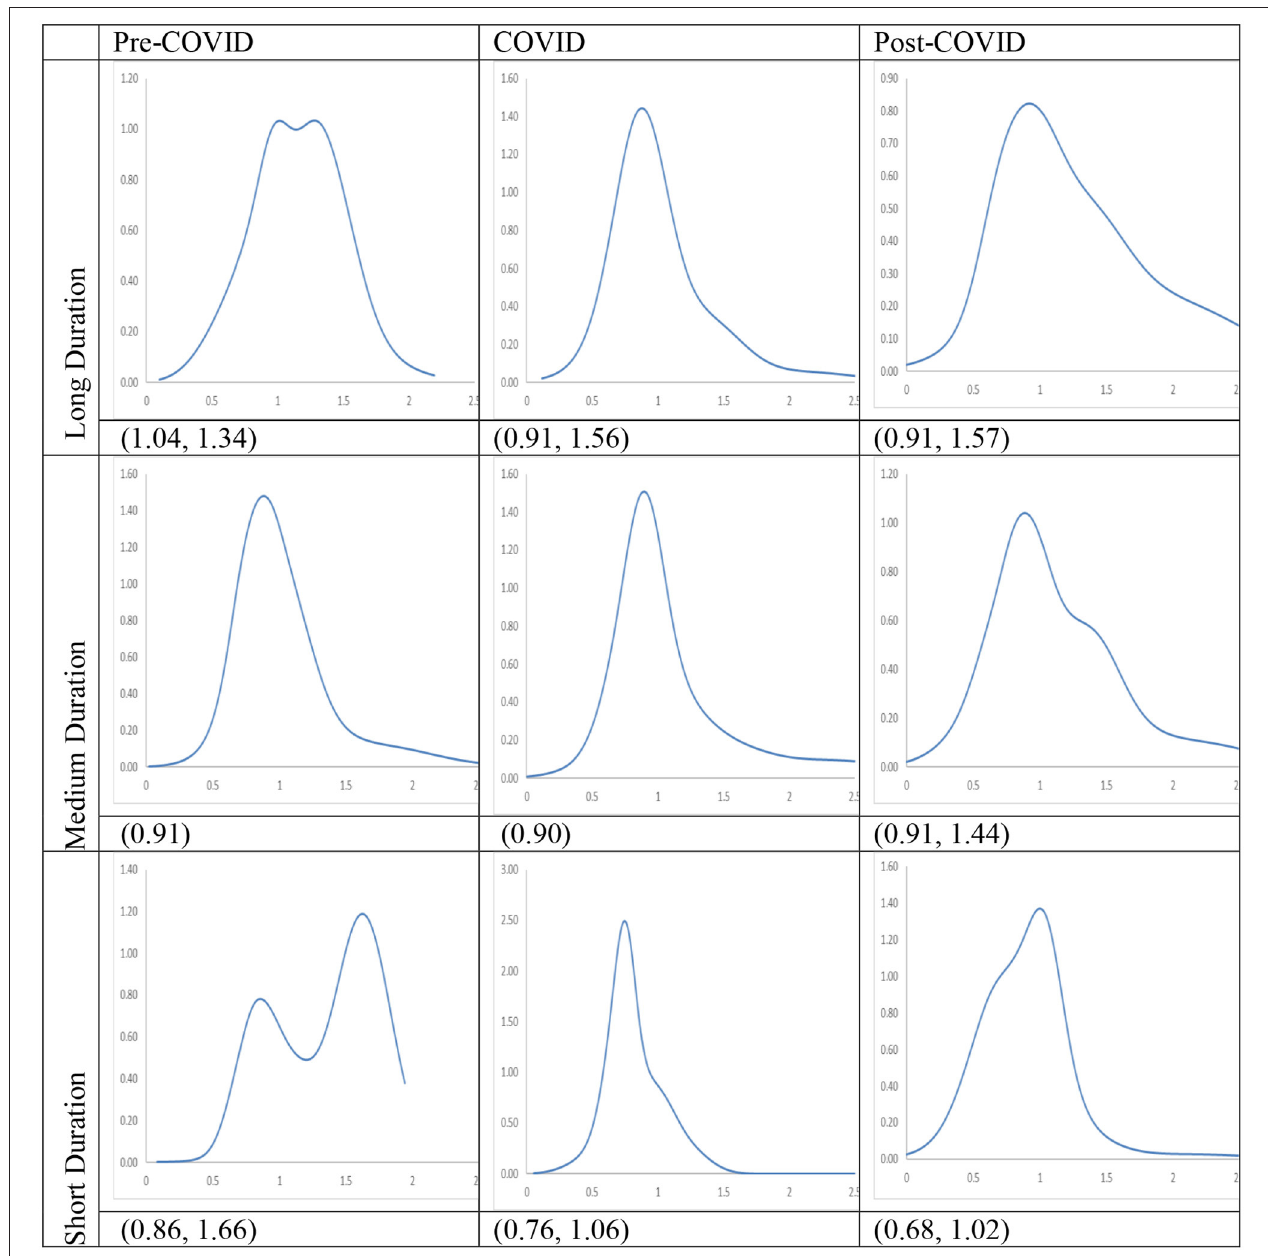
FIGURE 13 | Ergodic distributions for the RDIPC of urban residents in cities with long, medium, and short duration of Level I ERS. Source: authors’ calculation. N.B. The vertical axis indicates the density of probability, the horizontal axis indicates RDIPC values, and the value of the peaks are in parentheses.